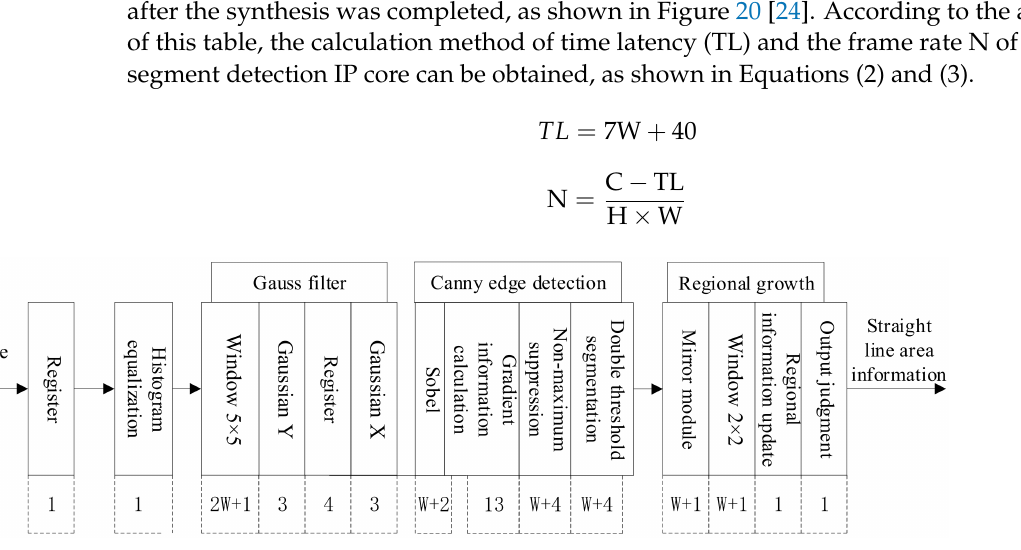
Figure 20. Algorithm clock delay analysis.